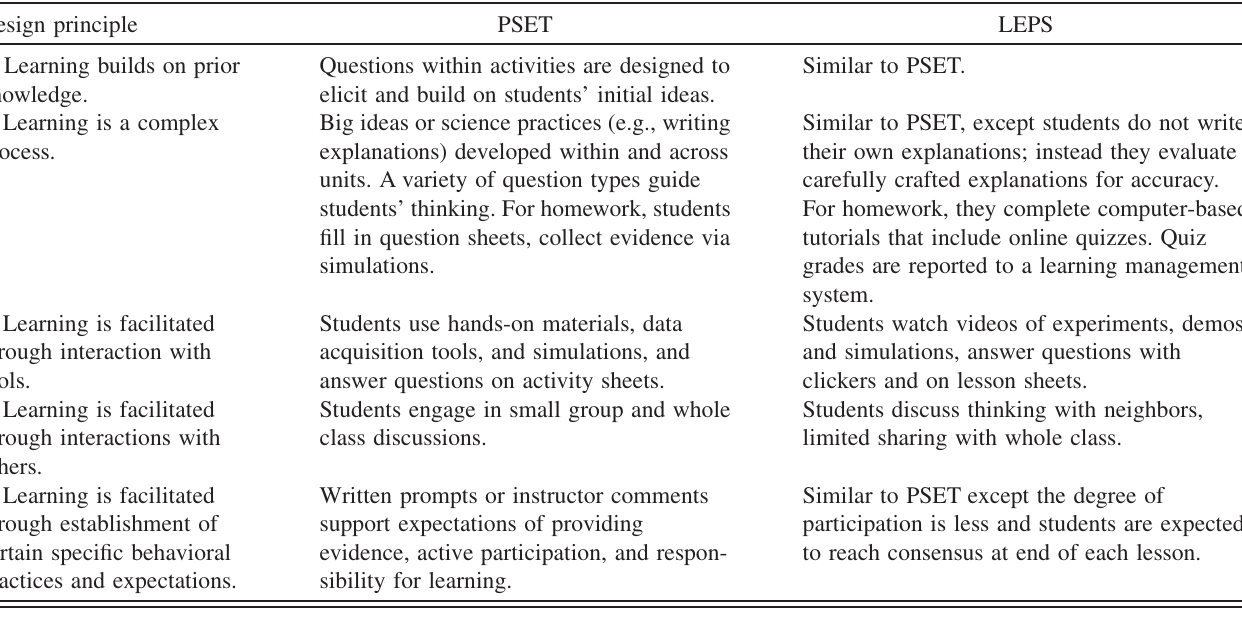
TABLE II. Design principles as implemented in PSET and LEPS.